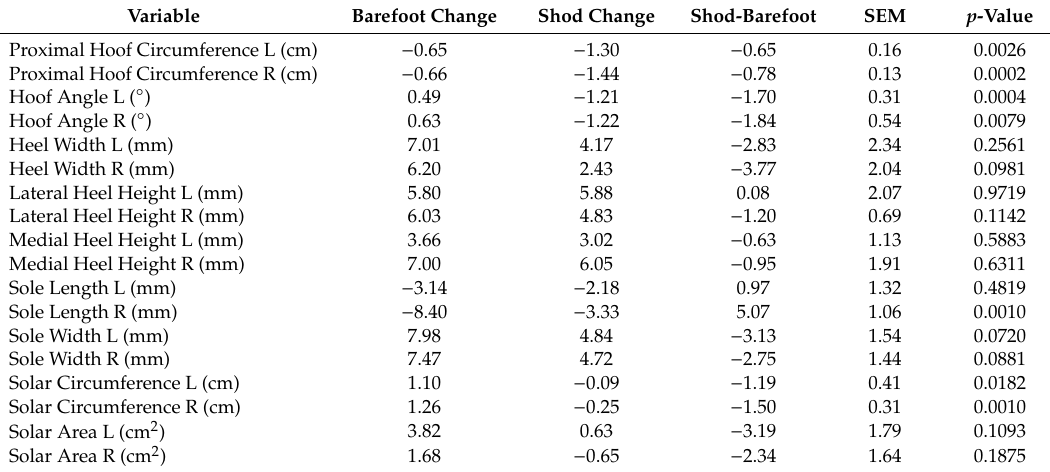
Table 2. Changes in hoof shape parameters when horses were barefoot versus shod over a seven-week period. The results are displayed as the mean change when horses were barefoot ( n = 11) versus shod ( n = 11), followed by the di ff erence between the two treatments and the standard error of the mean (SEM) di ff erence. Results are displayed for the left (L) and right (R) forelimbs. Variable Barefoot Change